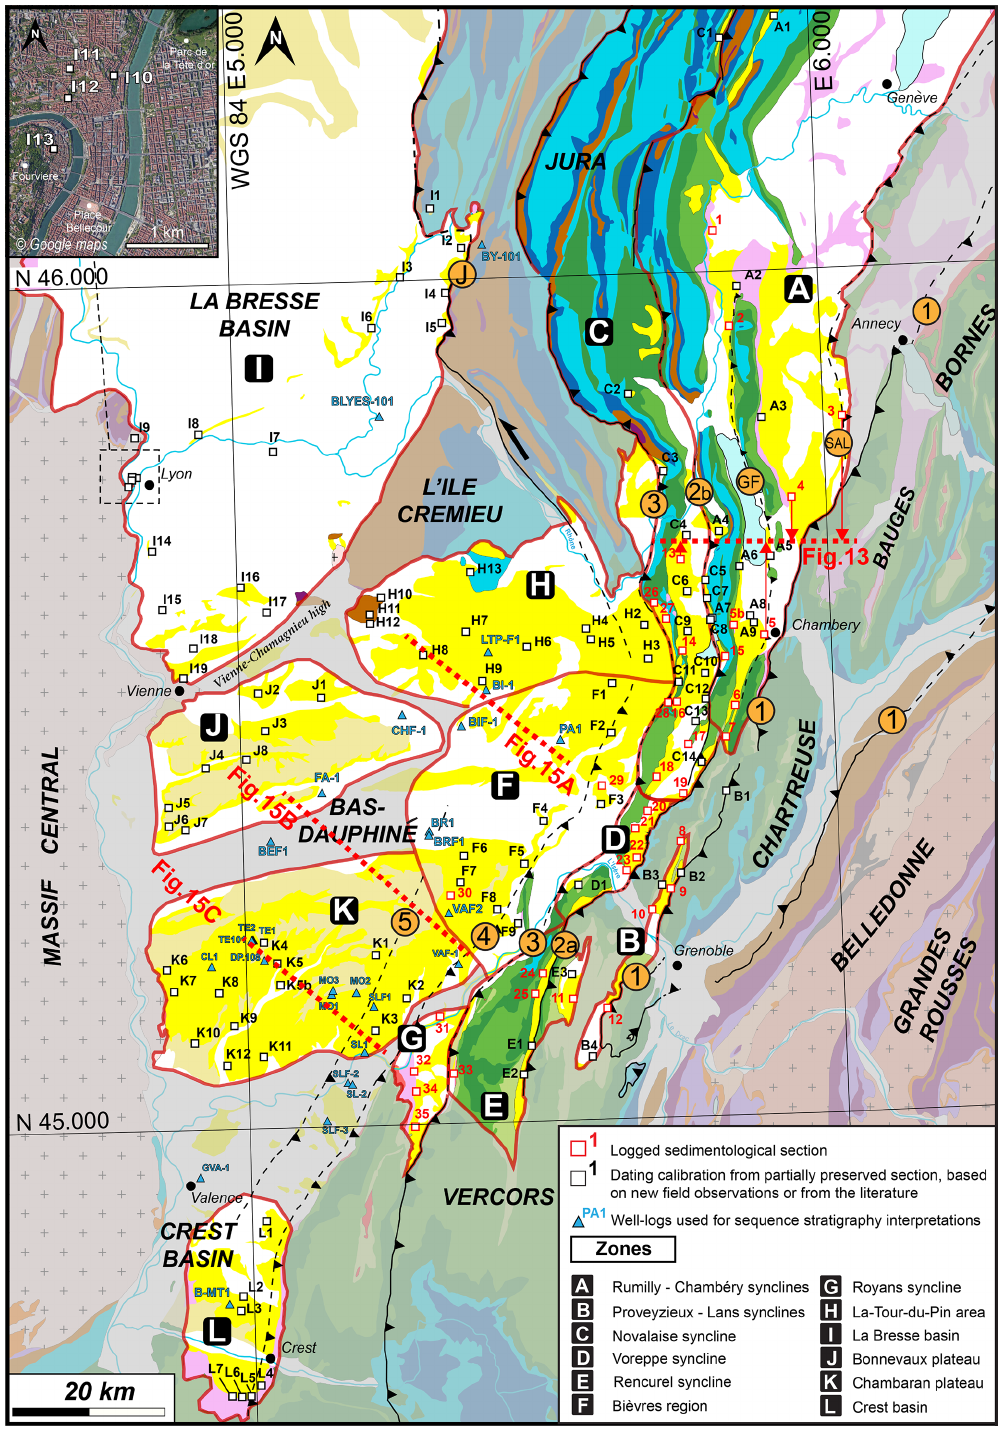
Figure 3. The 12 paleogeographical zones of the Miocene basin of the subalpine massifs, southern Jura, and adjacent basins (Bas-Dauphiné, La Bresse, Crest). Sedimentological and chronostratigraphical records of each zone are provided in Figs. S5 to S17.